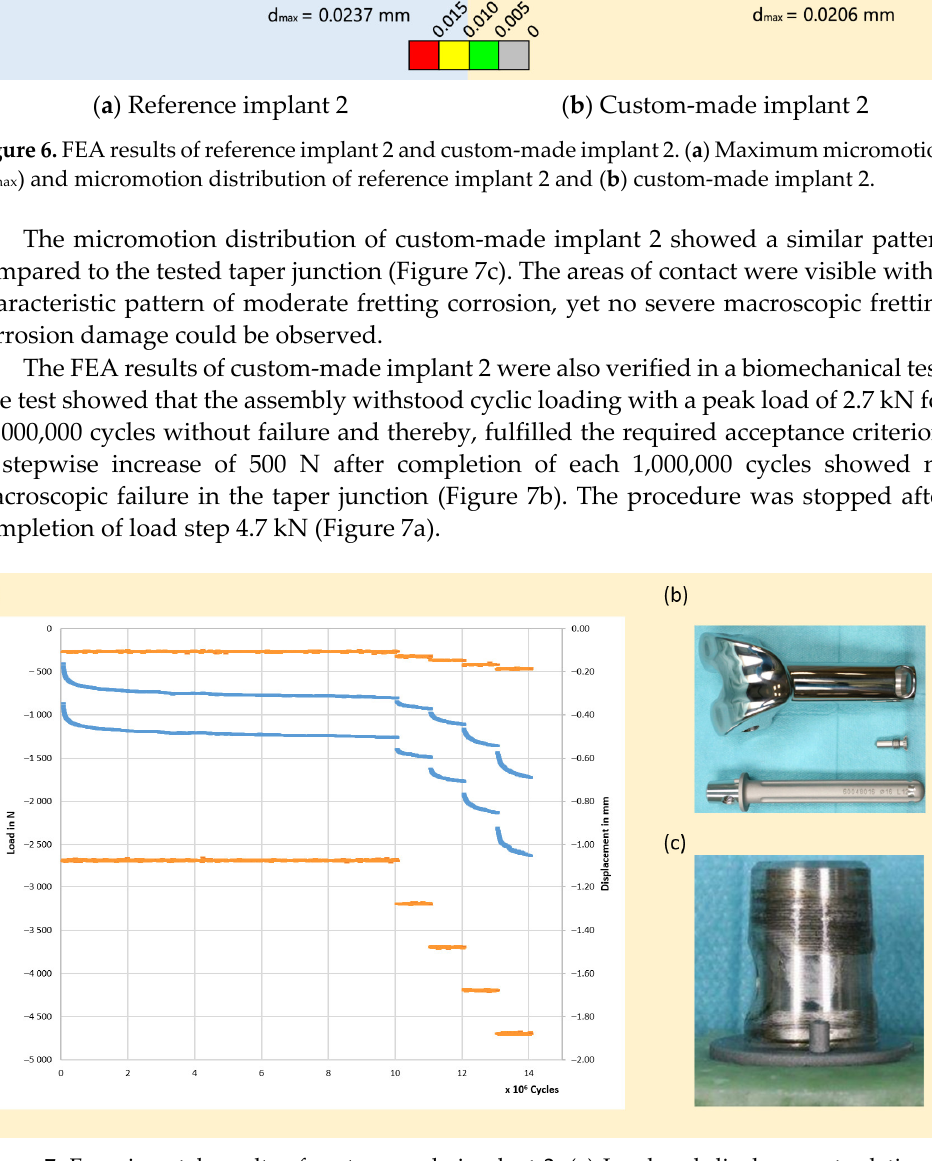
Figure 7. Experimental results of custom-made implant 2. ( a ) Load and displacement relative to cycles. ( b ) Components of custom-made implant 2 test assembly. ( c ) Taper junction of the stem connected to custom-made implant